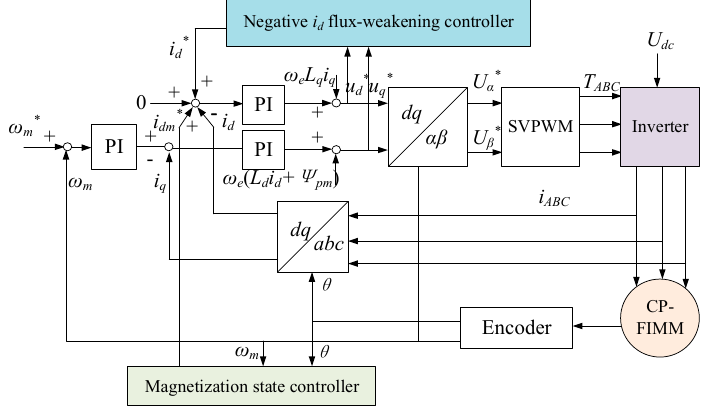
Figure 4. Control scheme of the CP-FIMM.